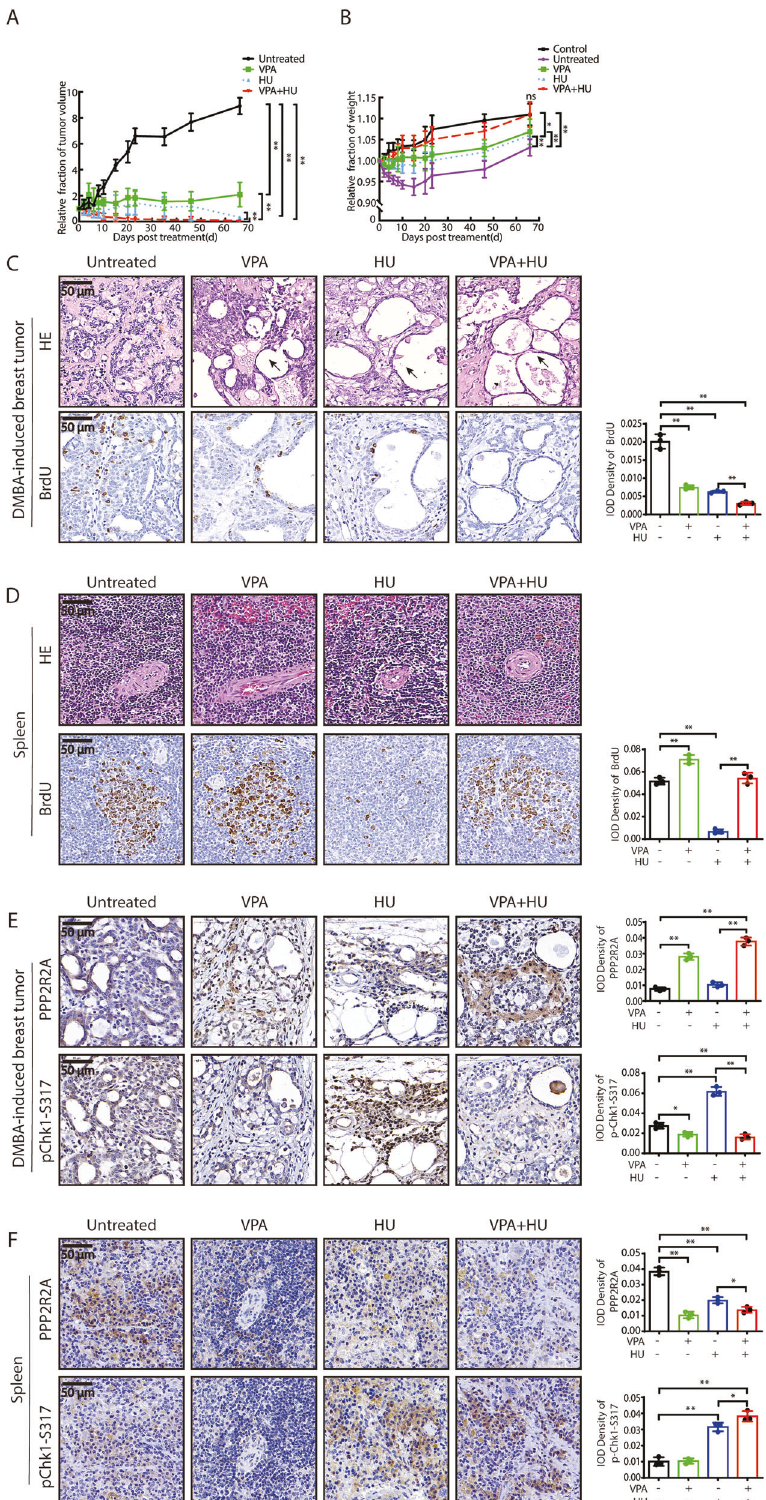
but enhanced the pChk1-S317 level in the spleen tissues (Fig. 4F, P < 0.01). Together, these data suggest there is a negative correlation between PPP2R2A and pChk1-S317, and VPA may exert bidirectional regulation through PPP2R2A-Chk1 signaling axis under HU treatment in vivo, which is consistent the in vitro